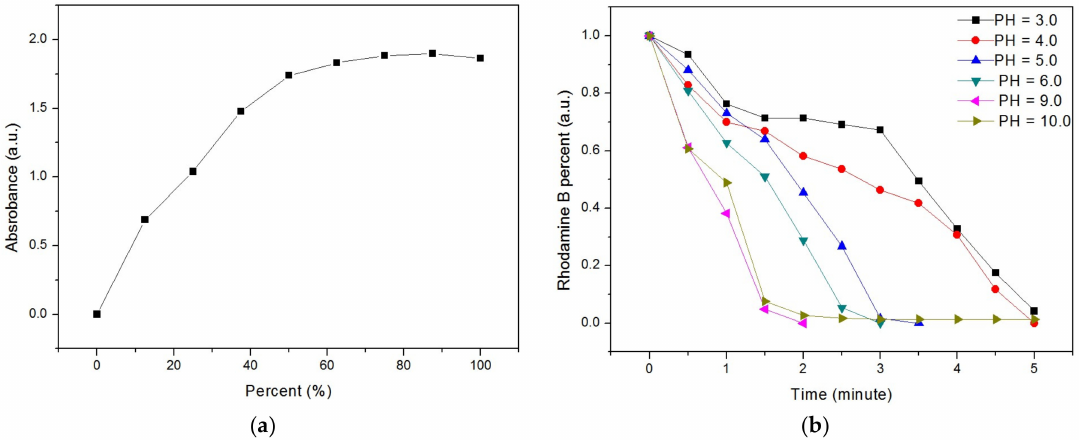
Figure 4. ( a ) Standard absorption pattern at 549.4 nm for Rhodamine B solution of different percentages. ( b ) Degradation of Rhodamine B at different pH